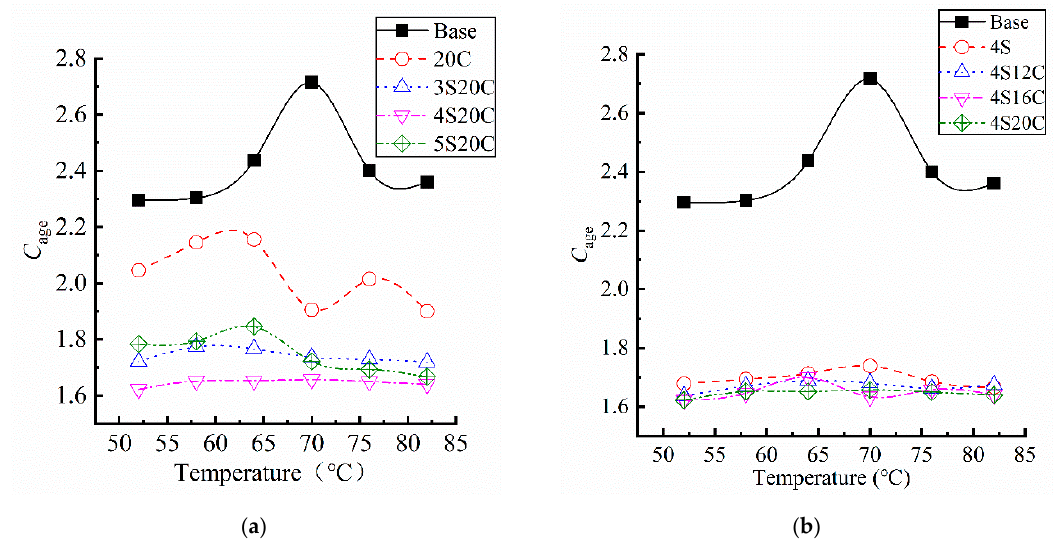
Figure 8. Complex modulus aging index ( C age ) of asphalt samples: ( a ) with different nano-SiO 2 , and ( b ) with different rubber powder.